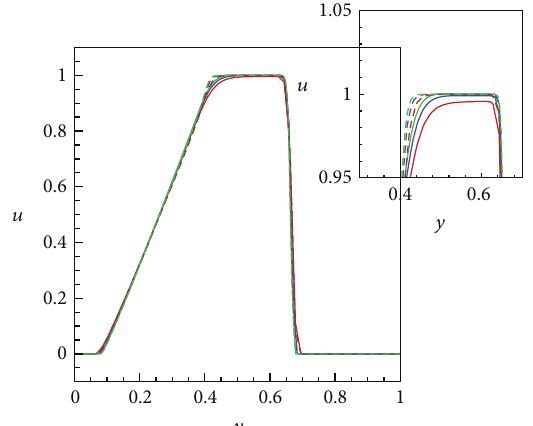
Figure 4: Instantaneous solutions, at 𝑋 = 0.5 and 𝑌 = 0.5 , of the nonlinear scalar equation (19) at time 𝑡 = 0.2 for 3rd- and 2nd-order CWENOreconstructionsandatvariousgridresolutions.Solidlines: 3rd order, dashed lines: 2nd order, red: 60 3 , blue: 80 3 , and green: 100 3 .